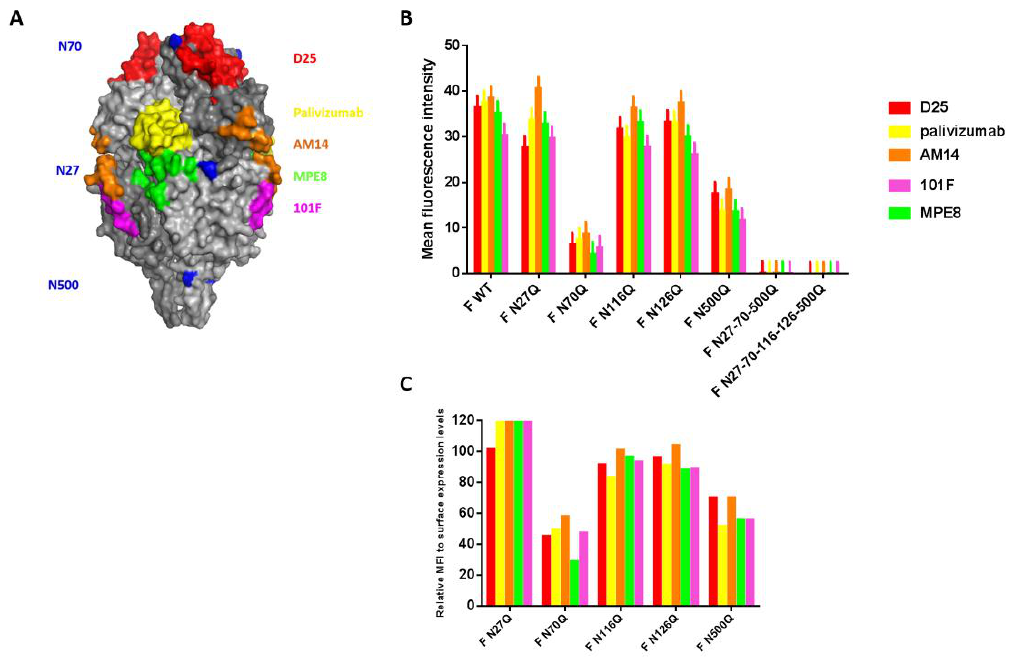
Figure 3. Evaluation of the effect of loss of N-glycosylation sequons on the recognition of RSV F-specific mAbs. ( A ) Surface representation of prefusion F. N-glycan structures are indicated in blue. MAb epitopes are highlighted in different colours. D25, red; palivizumab, yellow; AM14, orange; MPE8, green; 101F, magenta. ( B ) Flow cytometric analysis of BSR T7/5 cells expression glycosylation mutants of the RSV F protein. BSR T7/5 cells were transfected with a pCAXL plasmid encoding one of the glycosylation mutants of the RSV F protein and a GFP-expressing plasmid (EGFP-N3). After 24 h incubation the cells were detached and stained with RSV F-specific mAbs (palivizumab, AM14, D25, MPE8 or 101F) at 4 ◦ C. Secondary anti-human or anti-mouse IgG conjugated with AF647 were used to detect RSV F proteins. Fluorescence intensities of fluorescence channel (FL) 4 were measured of 5000 cells expressing GFP (FL1). The graph shows the surface expression expressed as the MFI ( ± SEM) from 3 independent repeats. There was no significant interaction between the recombinant F proteins and the binding of the different mAbs ( p = 0.741; F-test; two-way ANOVA). ( C ) Normalization towards protein surface expression levels expressed as relative MFI values to surface expression levels after staining with human RSV antiserum.